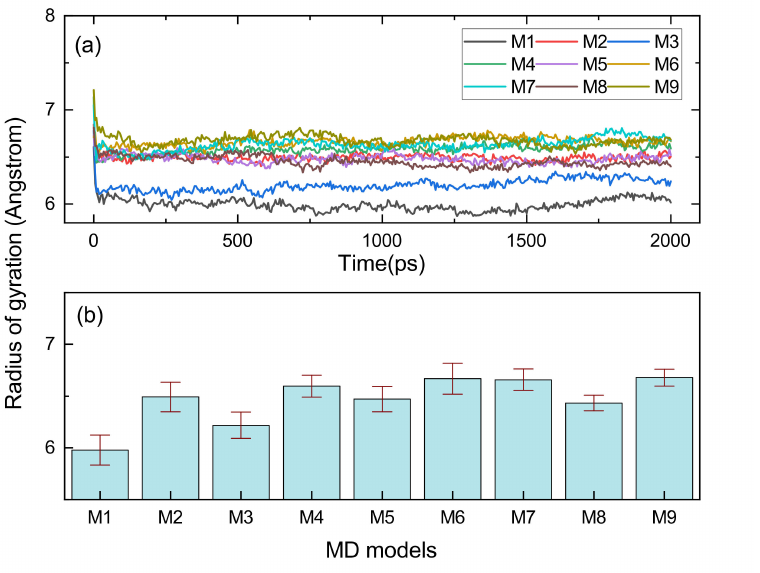
Figure 10. The Rg variation monitoring results when performing 2000 ps NPT MD simulation for EPDM models. ( a ) is the Rg evolution curve, ( b ) is the b is the Rg average value of three independent NPT simulations with standard deviation.